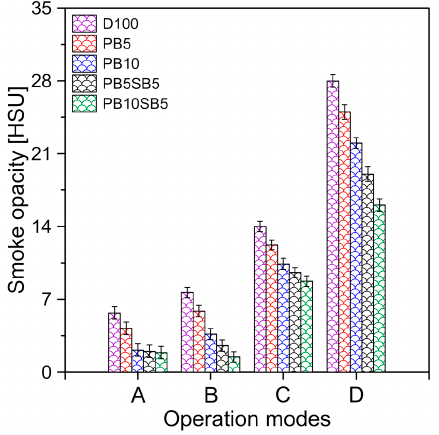
Figure 12. Smoke emissions for fuels tested.